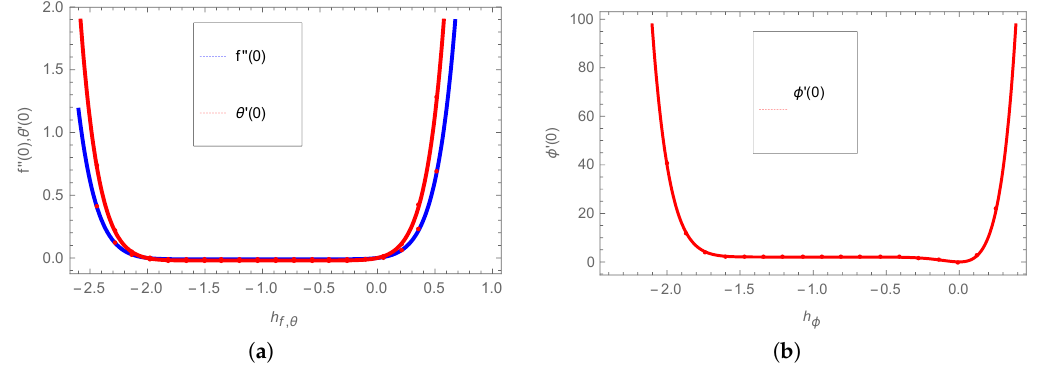
Figure 1. ( a , b ) ¯ h -curve representation of f ( η ) , θ ( η ) and φ ( η ) . Table 1. 25 th -order approximation table for HAM convergence, when γ 1 = Sc = 0.5, Nt = Gr = β = St = 0.1, h = − 0.5, Pr = Nb = Gm =